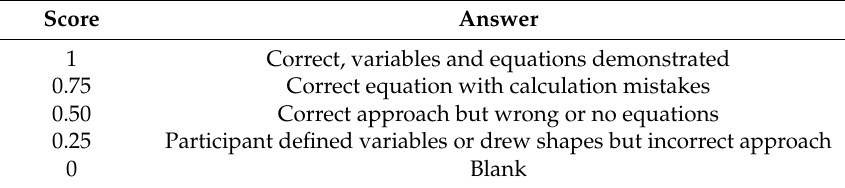
Table 2. Scoring